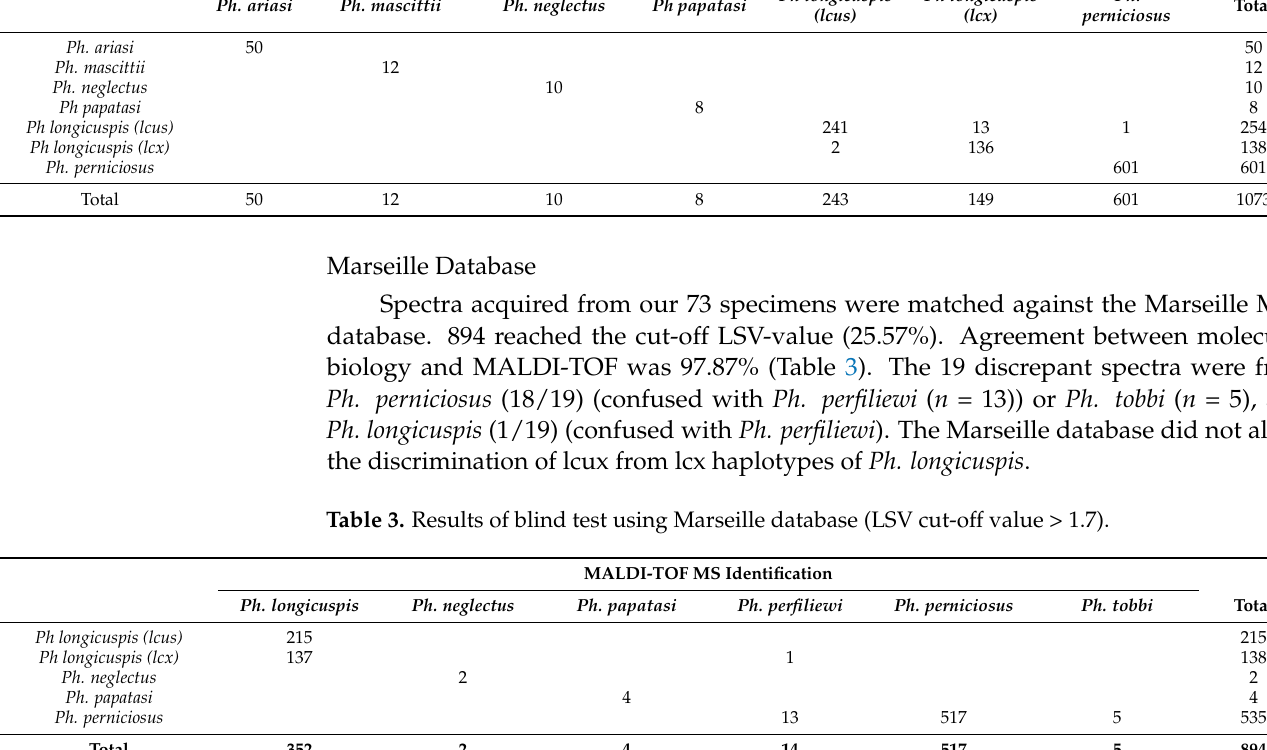
level, 97.1% at specimen level) between MALDI-TOF MS and molecular identification. Table 2. Evaluation of the in-house database (LSV cut-off value > 1.7). Table 2. Evaluation of the in-house database (LSV cut-off value > 1.7). MALDI-TOF MS Identification MALDI-TOF MS Identification